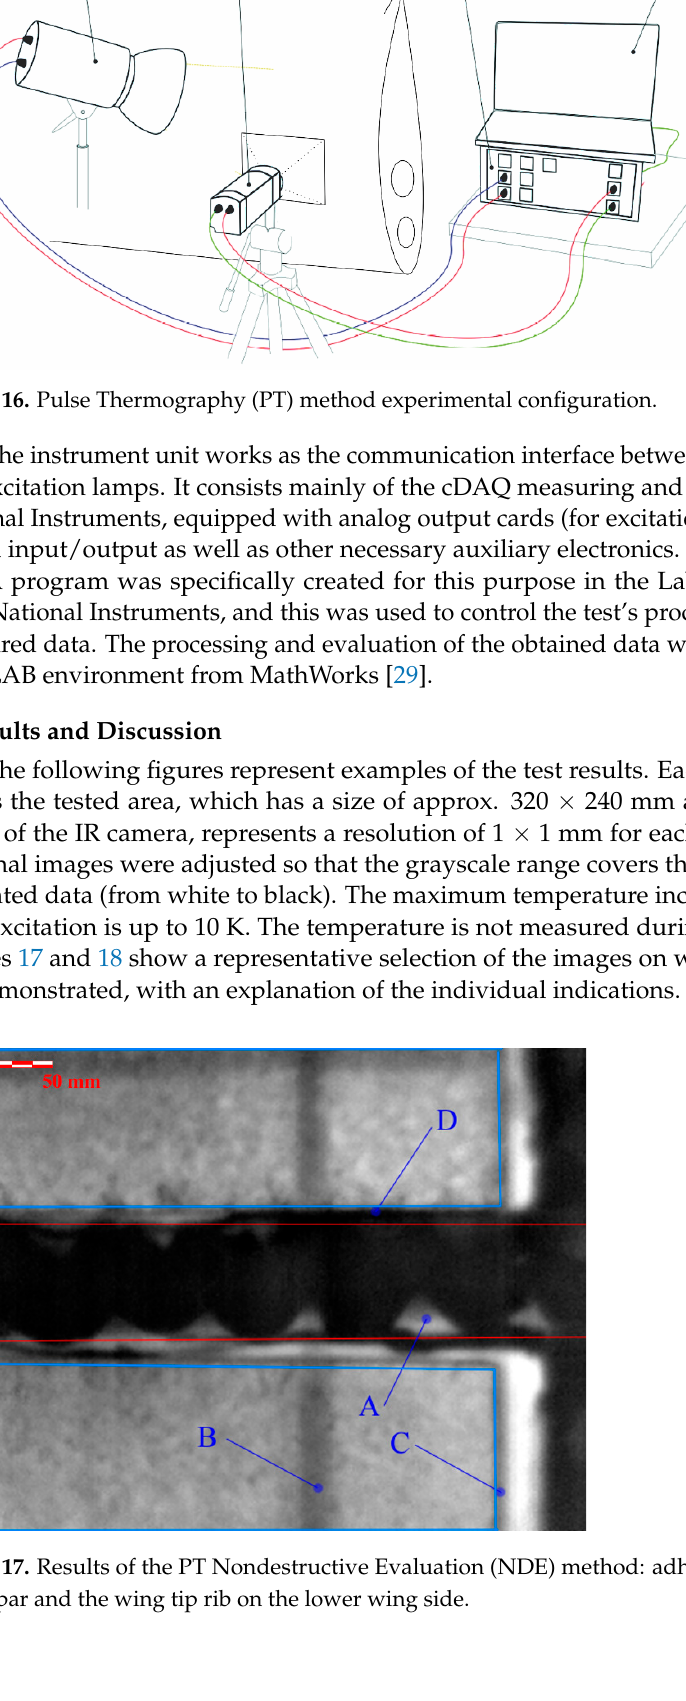
( b ) Figure 15. Comparison of the resulting images: ( a ) RAW thermal data; ( b ) modified DAC-processed data. 2.3. Experimental System Description A modular test system was designed and employed for the PT NDE method. The experimental setup can be seen in Figure 16 . The basic hardware elements of this system consist of a FLIR A325SC bolometric uncooled IR camera (resolution 320 × 240 pixels; NETD < 50 mK; maximum scanning frequency, 60 Hz), an instrument unit equipped with a PC for test control and data recording and two flash lamps (2 × 1200 Ws). The instrument unit works as the communication interface between the PC, IR cam- era and excitation lamps. It consists mainly of the cDAQ measuring and control system